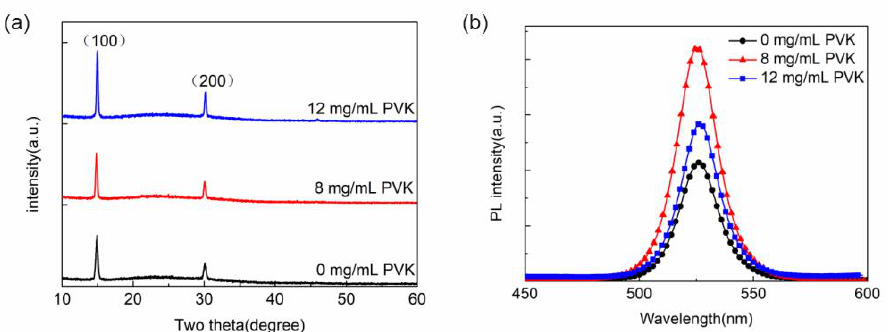
Figure 5. XRD spectra ( a ) and PL spectra ( b ) of perovskite films prepared on PEDOT:PSS/PVK double-layer HTL.